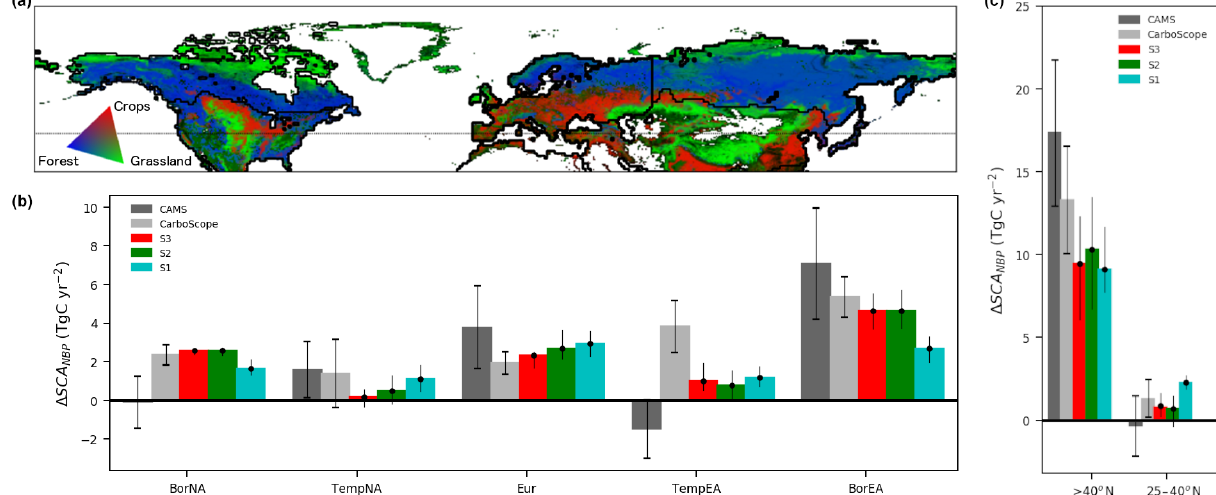
Figure 2. Regional distribution of the dominant land-cover types and SCA NBP trends. (a) Land-cover map averaged over the study period for the three main land-cover classes (forest–shrubland, grassland and cropland) based on ESA-CCI annual land-cover data (1992–2015 average). (b) The continental regions correspond to the regions defined by Baker et al. (2006) and are delimited by bold lines: boreal and temperate North America (BorNA and TempNA), Europe (Eur), and boreal and temperate Eurasia (BorEA and TempEA). (c) Comparison of the SCA NBP trends from the inversions to the trends estimated by the LSM experiments: S3, S2 (no LULCC) and S1 (no LULCC and no climate change). The bars for the inversions and LSMs indicate the average trend over each latitudinal band. The error bars for the inversions indicate the 95% confidence levels for the trend values, and the vertical lines for the LSMs indicate interquartile ranges of the multi-model ensemble. The 95% confidence interval for the MMEM was also calculated (see